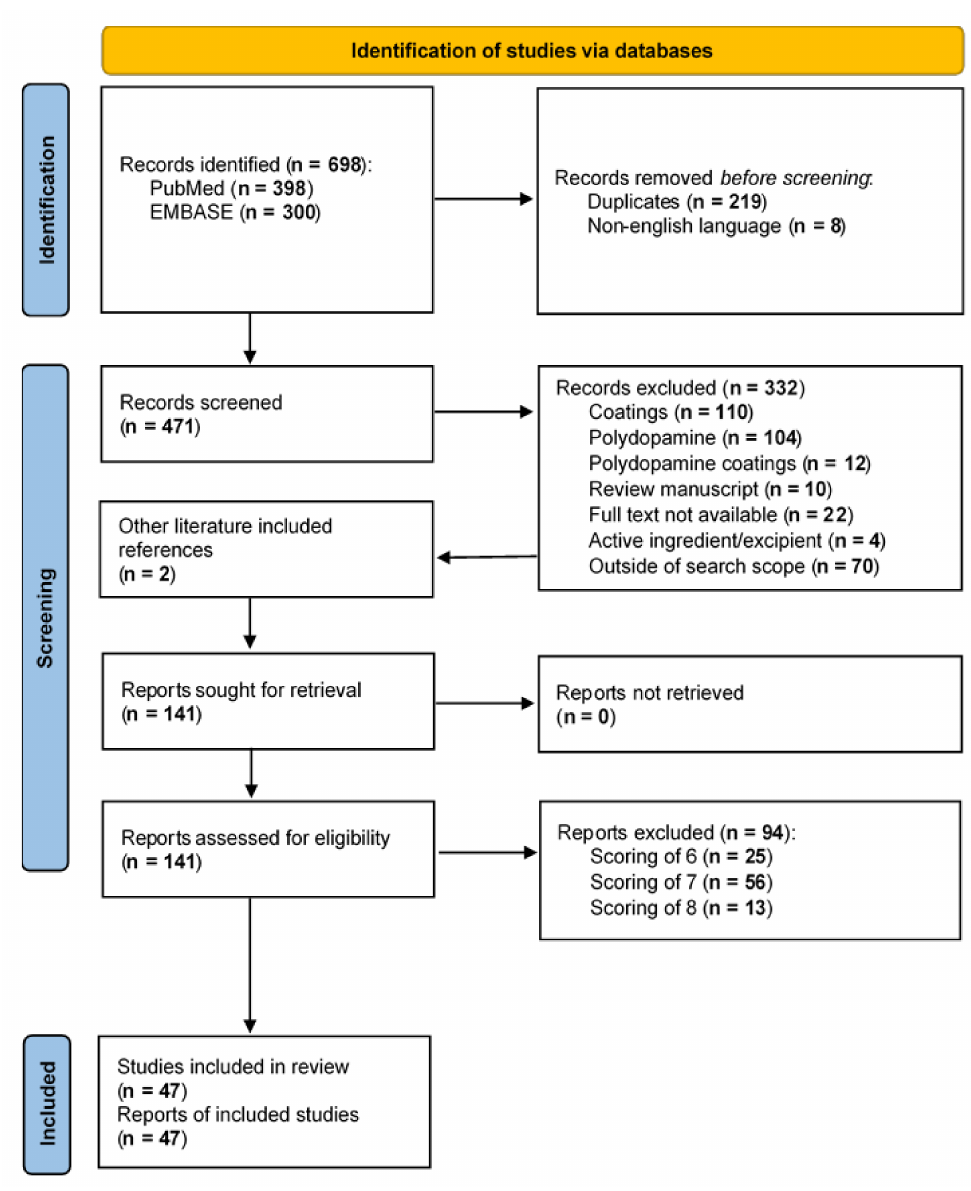
Figure 2. PRISMA flow chart. Adapted from [12].